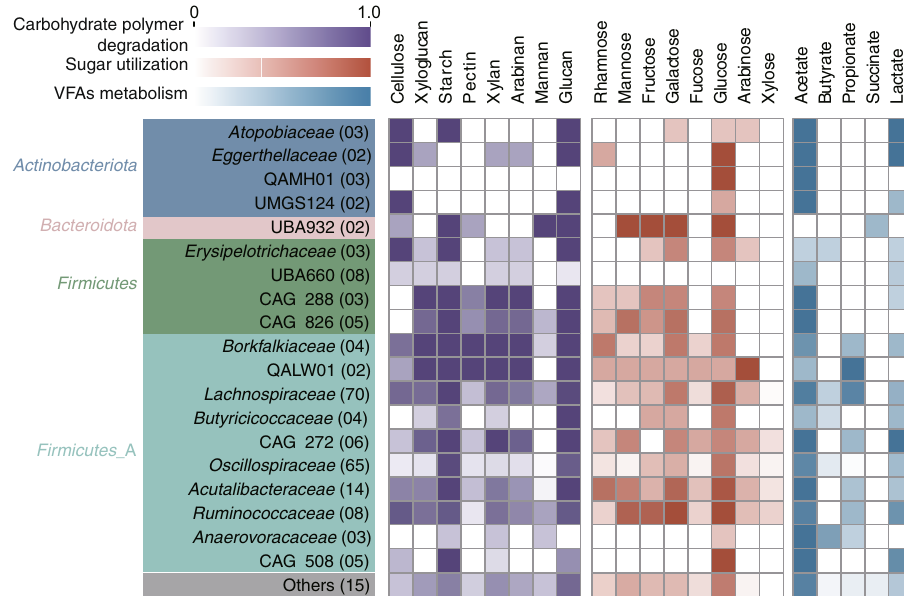
Fig. 7 Metabolic reconstruction of MAGs enriched in high-leaf diets. Heatmap indicated the proportions of MAGs with the abilities for major polysaccharides degradation, sugar utilization, and fermentation. The MAGs were summarized into family-level taxonomic clades based on the phylogeny inferred by GTDB-Tk. Functional pro fi les were reconstructed inferred from the presence of the key marker genes within the metabolic pathway. Detailed information was provided in Supplementary Table